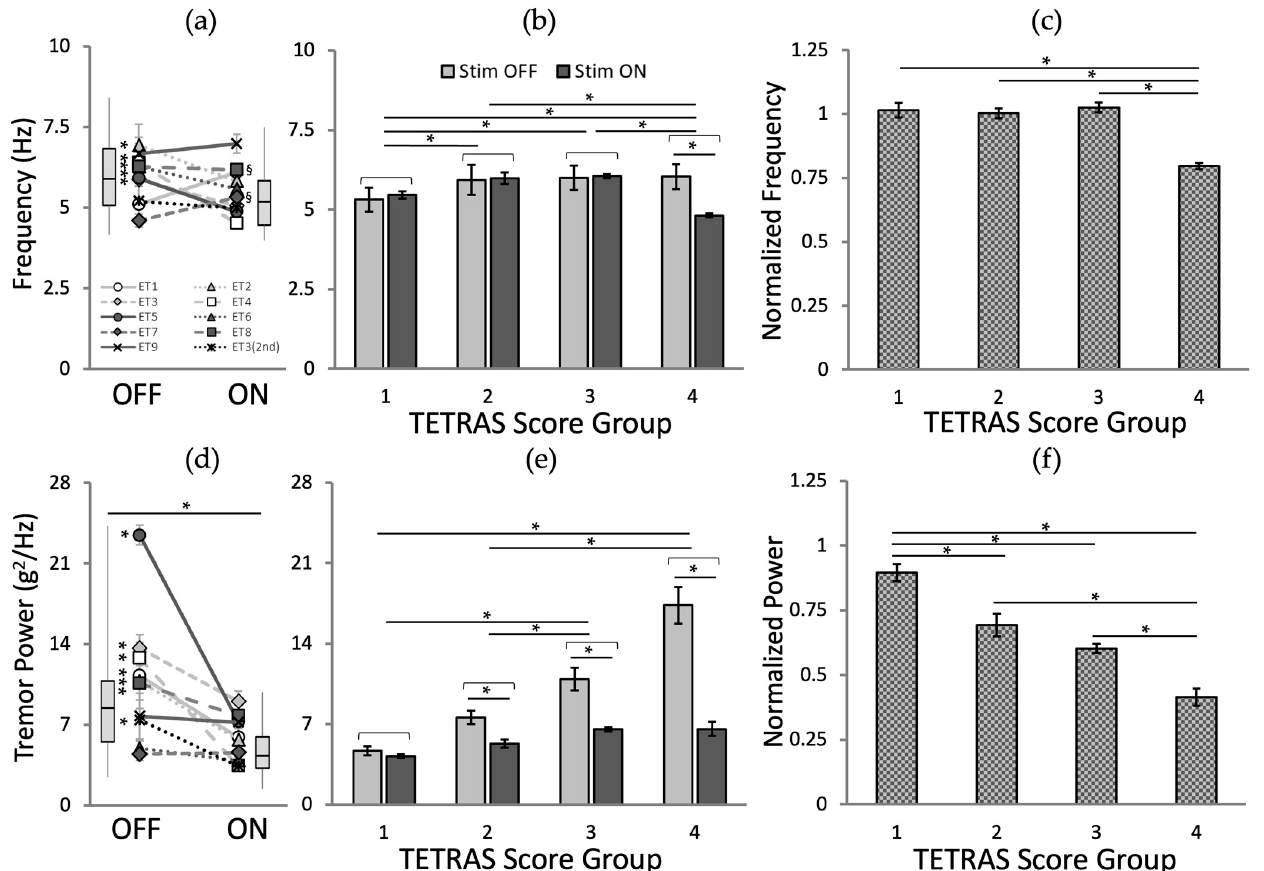
Figure 6. Effects of peripheral nerve stimulation. Overall tremor movement without and with stimulation for tremor metrics: dominant frequency (upper panels) and tremor power (bottom panels). The overall effect of stimulation (boxplots) with the effects of individual subjects for tremor metrics: ( a ) tremor frequency and ( d ) power. The effect of stimulation by TETRAS score groups for tremor metrics: ( b ) tremor frequency and ( e ) power. The normalized tremor metrics (metrics of stimulation/metrics of control) by TETRAS score group for tremor metrics: ( c ) tremor frequency and ( f ) power. The error bars represent standard errors of the mean. *: p < 0.05 for significant decrease; § : p < 0.05 for significant